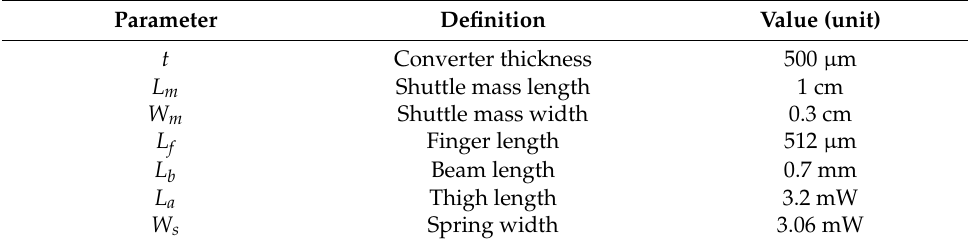
Table 1. A summary of the main technological design